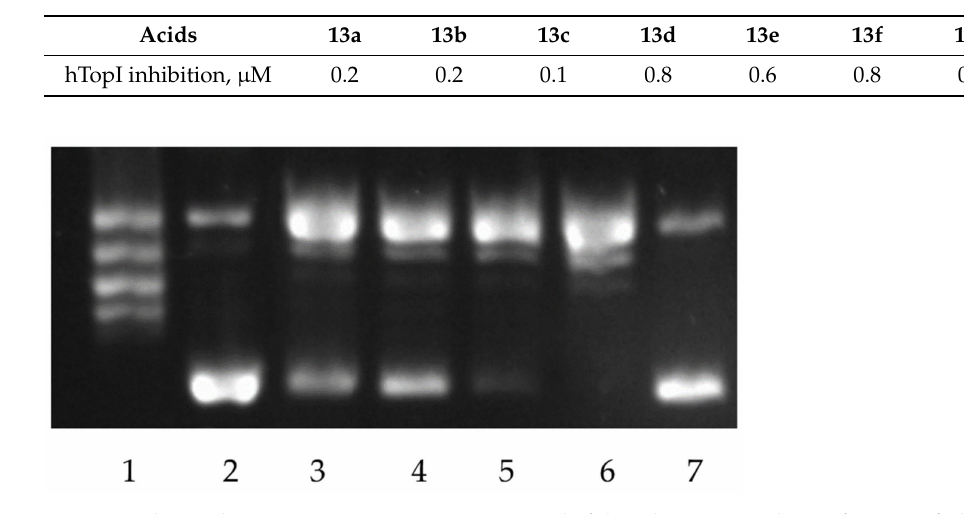
Figure 5. Electrophoretic separation in 2% agarose gel of the relaxation products of 250 ng of plasmid DNA (pHOT1) in vitro under the action of 4 U of topoisomerase I (TG-1018-2 Topoisomerase I Drug Screening Kit, Topogen, Buena Vista, CO, USA) in the presence of natural 5 Z ,9 Z ,13 Z -docosatrienoic acid 13c (the test compounds were added before the addition of topoisomerase I). (Lane 1) Relax DNA; (Lane 2) Supercoiled DNA; (Lane 3) 13c , 0.1 µ M; (Lane 4) 13c , 0.05 µ M; (Lane 5) 13c , 0.02 µ M; (Lane 6) No compound; (Lane 7) Camptotecin, 0.5 µ